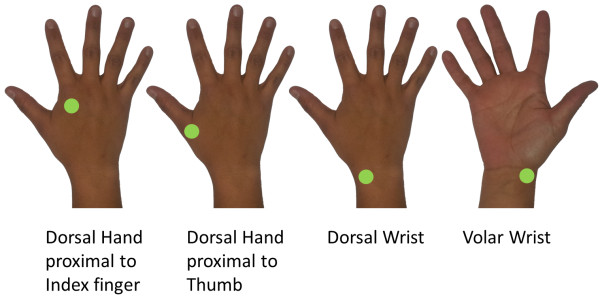
Vibrotactile noise locations. Sensation scores were recorded while remote vibrotactile noise was applied to one of four locations: 1) dorsal hand approximately 2 cm proximal to the index finger knuckle; 2) dorsal hand approximately 2 cm proximal to the thumb knuckle; 3) dorsal wrist, medial to the radial styloid process; and 4) volar wrist, medial to the radial styloid process. Noise intensity was set to 40%, 60%, or 80% of the sensory threshold for each location for each stroke survivor.